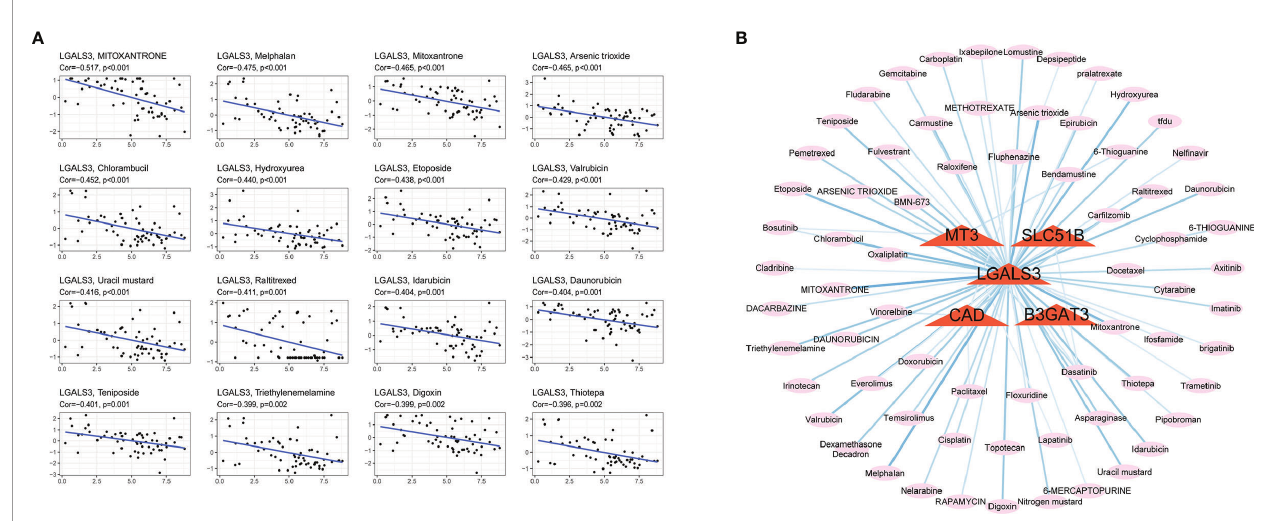
FIGURE 9 | Screening for sensitive drugs. (A) The top 16 most relevant negative correlations. (B) The network between fi ve genes and sensitive drugs with negative IC50s (R< − 0.25, P < 0.05). Stronger correlations are represented by a thick dark blue